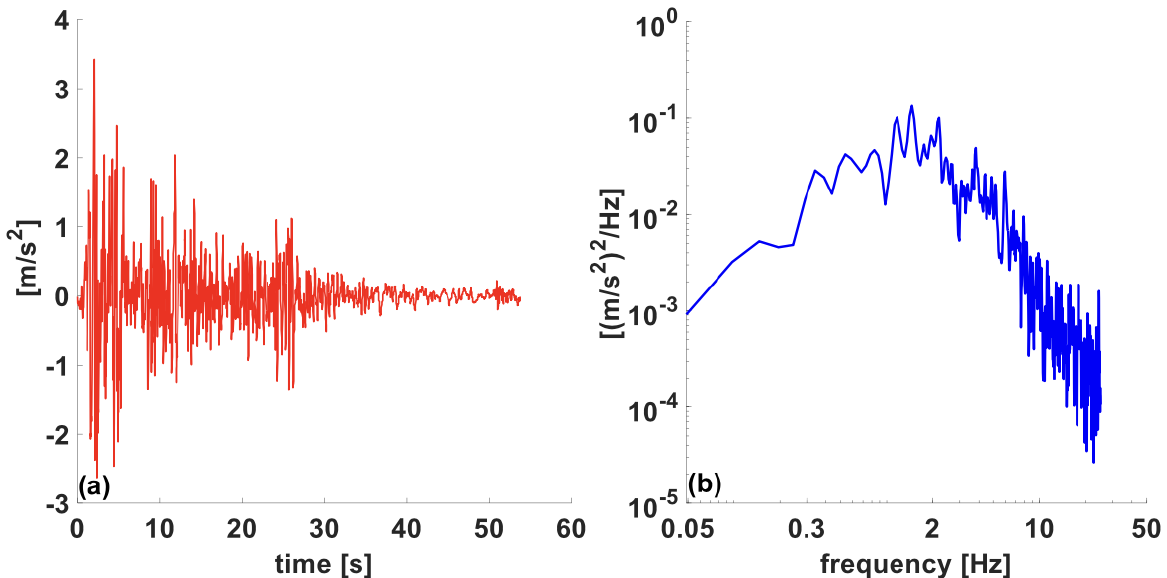
Figure 15. El-Centro earthquake excitation: ( a ) acceleration time history, and ( b ) acceleration spectrum.